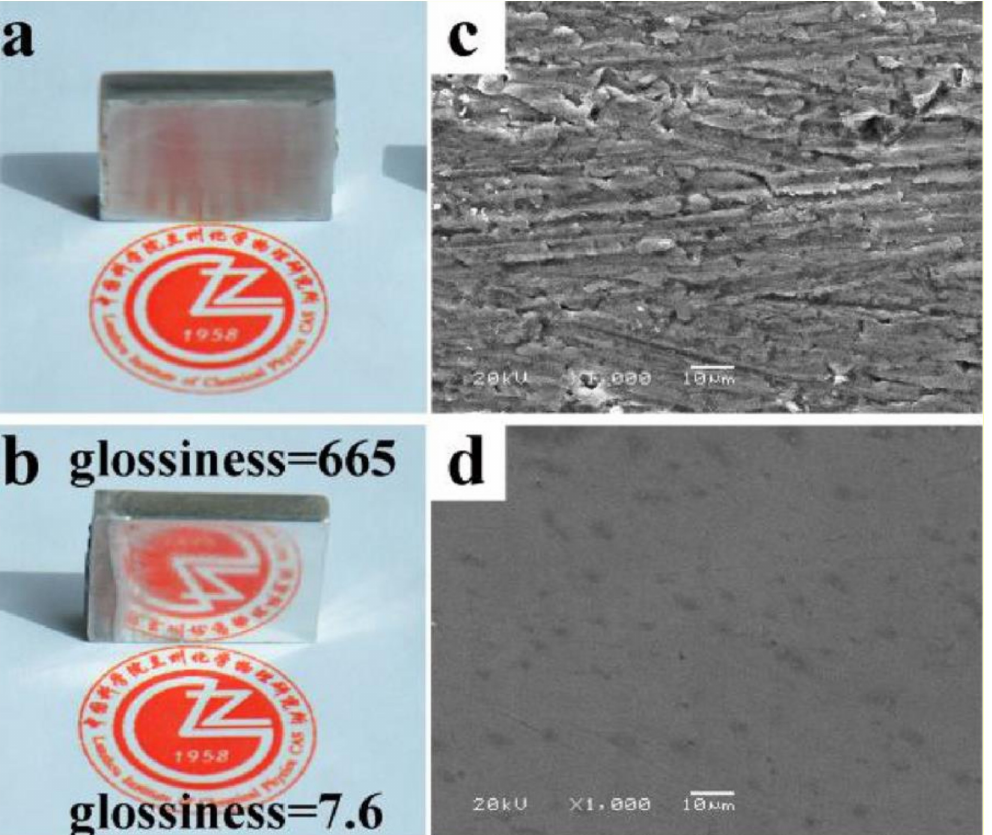
Figure 10. Photographs ( a , b ) and SEM images ( c , d ) of the Al sample before ( a , c ) and after ( b , d ) electropolishing in an anhydrous aluminum chloride–trimethylamine hydrochloride mixture (reprinted with permission from ref. [48]; Copyright 2017